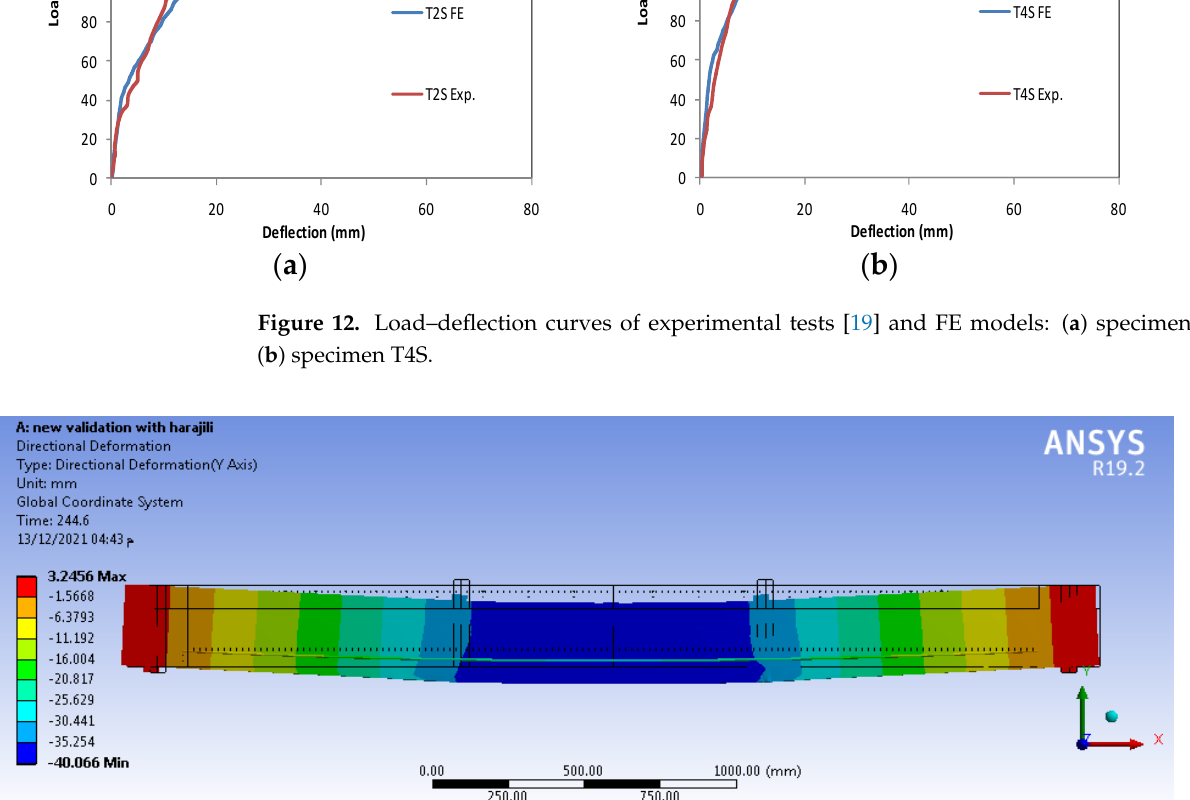
Figure 13. Deflection of sample T2S at failure.